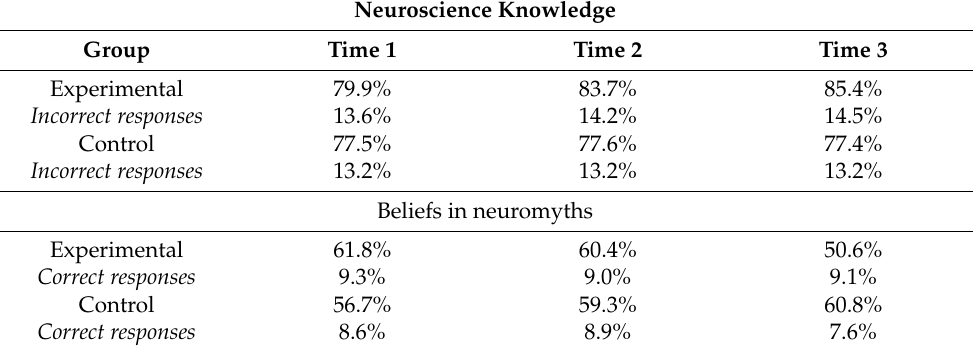
Table 1. Neuroscience literacy and beliefs in neuromyths of control and experimental groups at Times